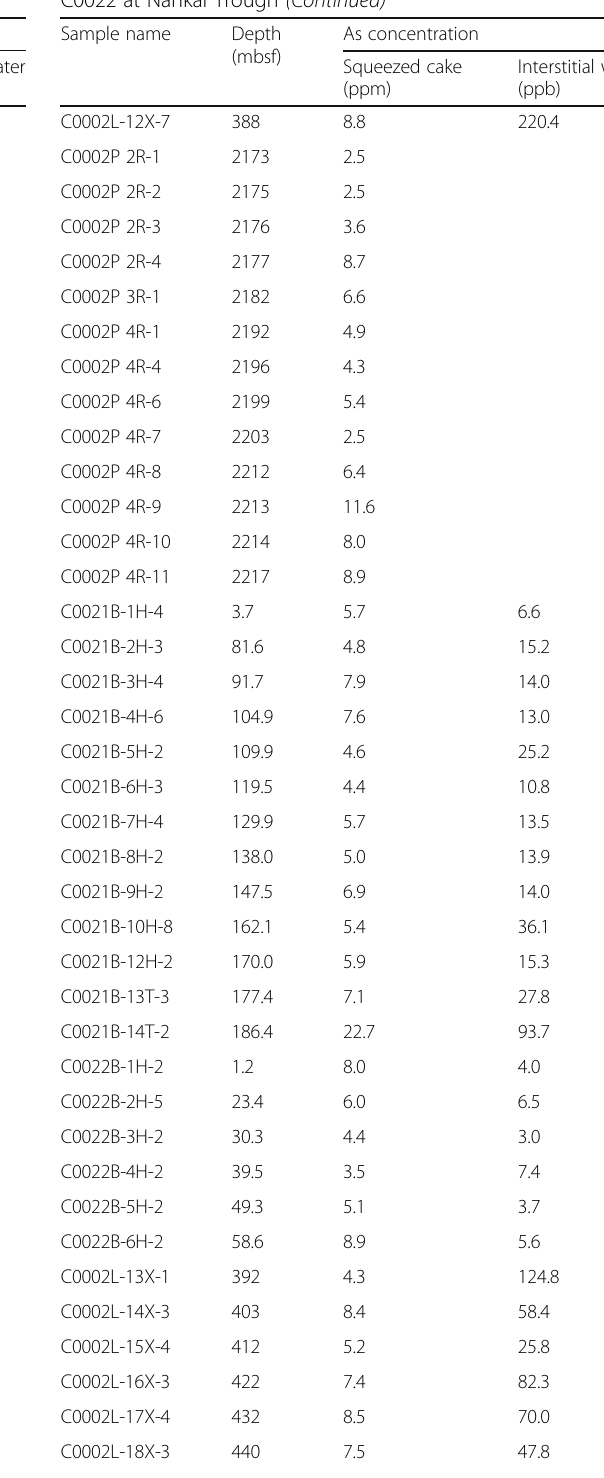
Table 1 Total arsenic concentration of squeezed cake and interstitial water of sediments from the Sites C0002, C0021